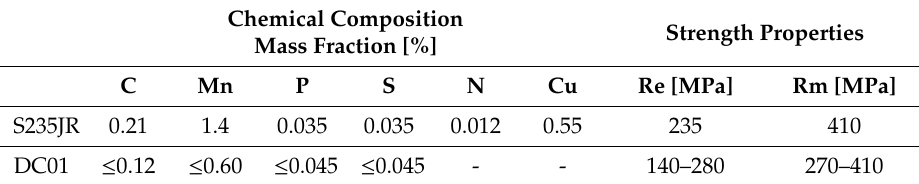
Table 1. Steel chemical composition and strength properties.